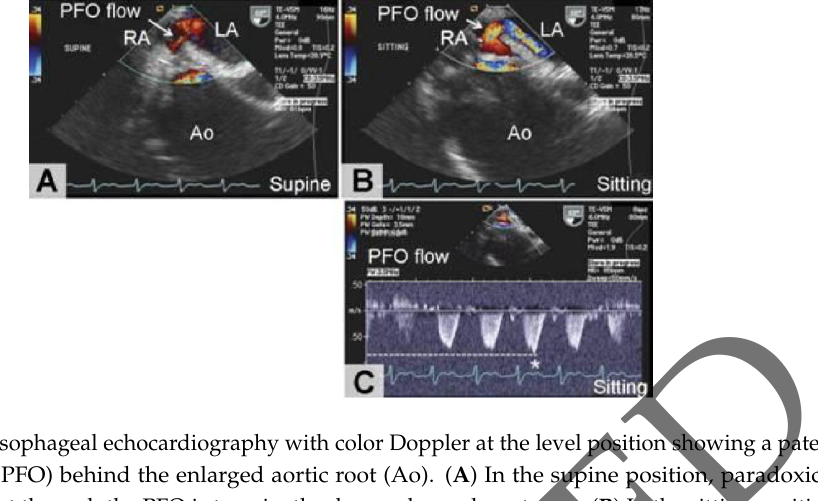
Figure 2. Transesophageal echocardiography with color Doppler at the level position showing a patent foramen ovale (PFO) behind the enlarged aortic root (Ao). ( A ) In the supine position, paradoxical right ‐ to ‐ left shunt through the PFO is transiently observed as only a stream. ( B ) In the sitting position, the shunt grows to a massive jet. ( C ) A continuous ‐ wave Doppler recording shows that shunt flow is observed in the systolic phase, with a peak velocity of 0.86 m/s (asterisk) and a calculated pressure gradient of 2.9 mmHg. (LA = left atrium; RA = right atrium.)